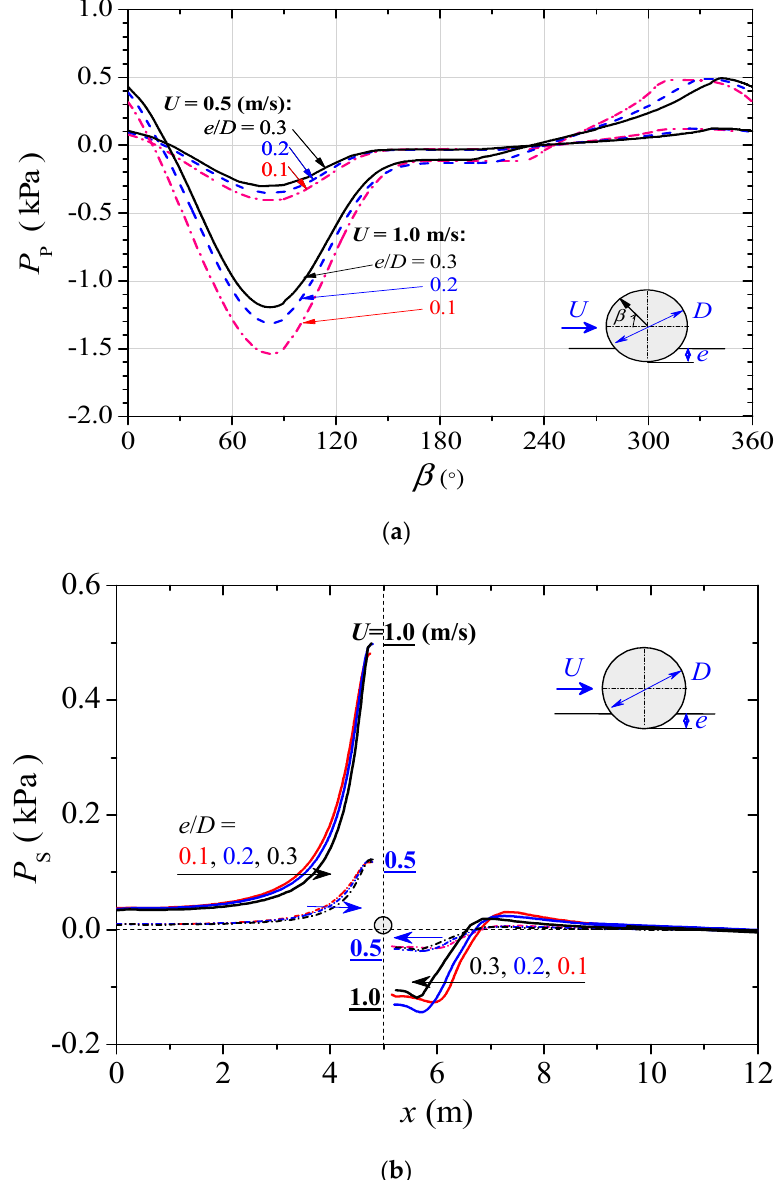
Figure 10. Pressure distributions along ( a ) the pipe surface ( P P ) and ( b ) the mudline near the pipe ( P s ) for various e/D and U .